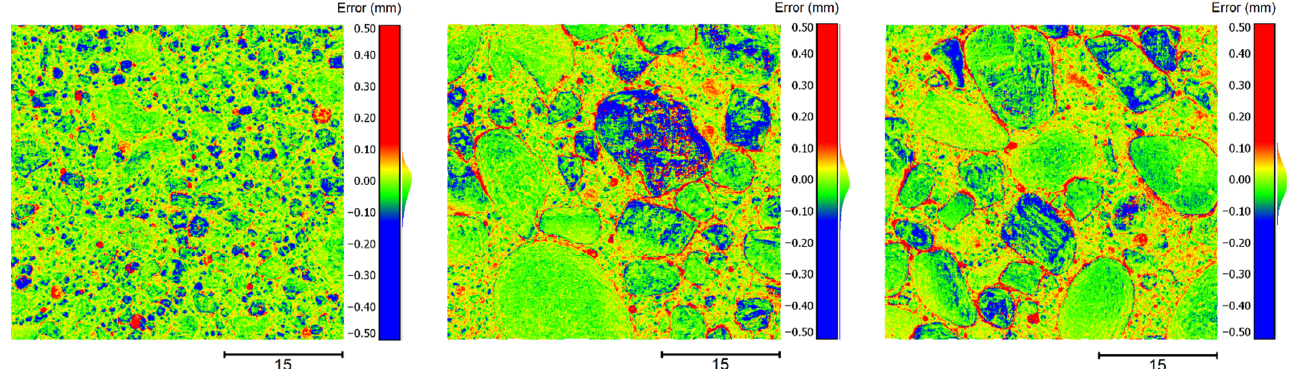
Figure 9. False color maps depicting the point deviations of the point clouds to the reference meshes—to the left specimen 1, in the center specimen 2 and to the right specimen 3.